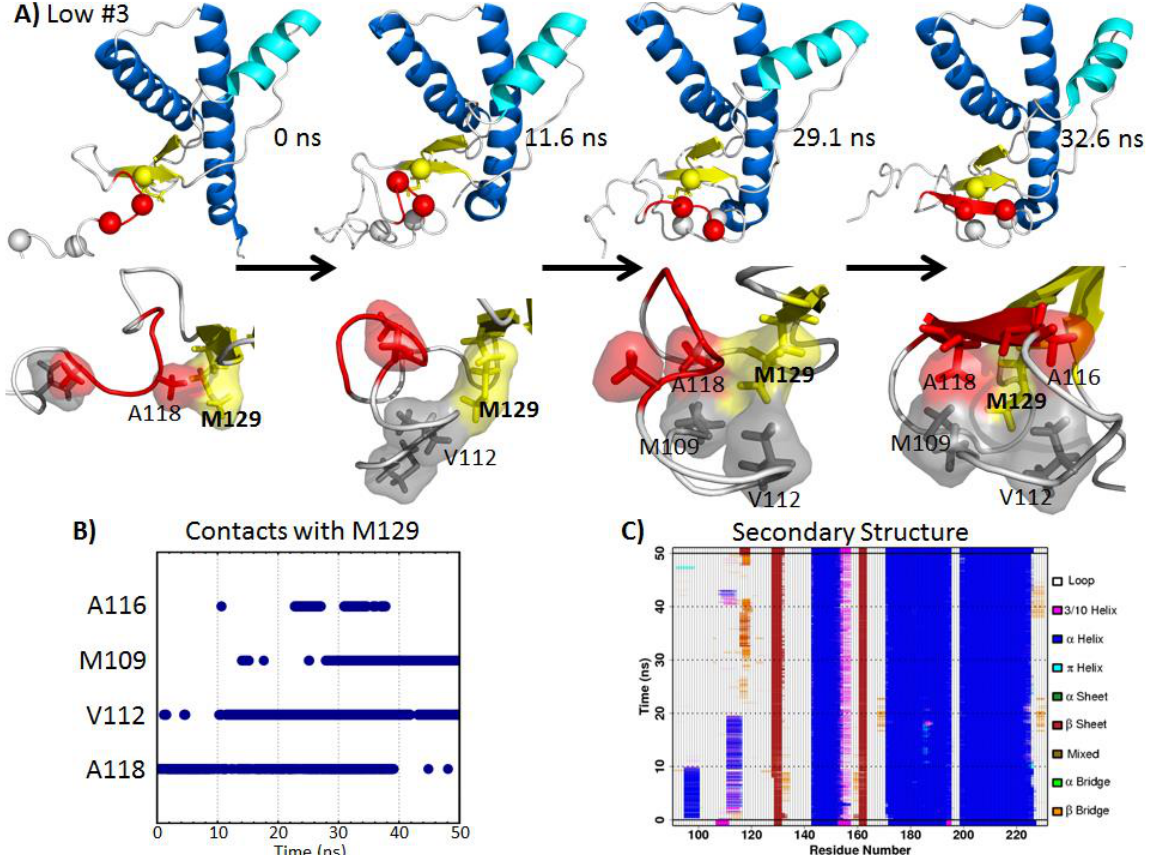
Figure 6. Illustration of nonnative β-strand formation at the N -terminus facilitated by N -terminal hydrophobic contacts with M129 in low pH Simulation 3. (A) The top panel shows the bovine PrP, with important hydrophobic residues indicated by spheres. Residues in red participate in the nonnative β-strand. The lower panel shows the close-up view of M129 and the neighboring residues. (B) Hydrophobic contacts with M129 over time. (C) PrP secondary structure, where orange and red regions indicate β-structures. A nonnative strand was formed from ~30–42